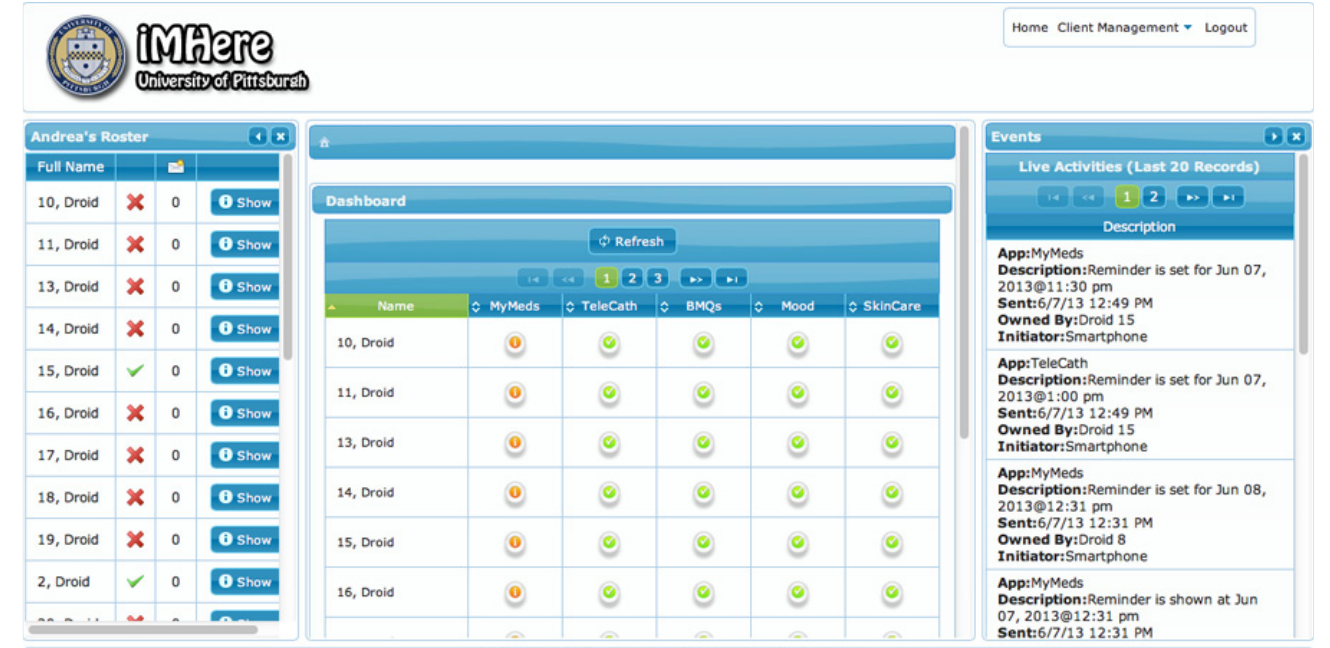
Figure 8: iMHere Clinician Dashboard provides a graphical overview of incoming information from the patients’ apps. Clinicians can quickly scan the dashboard and determine how to prioritize contact with patients based on this information.